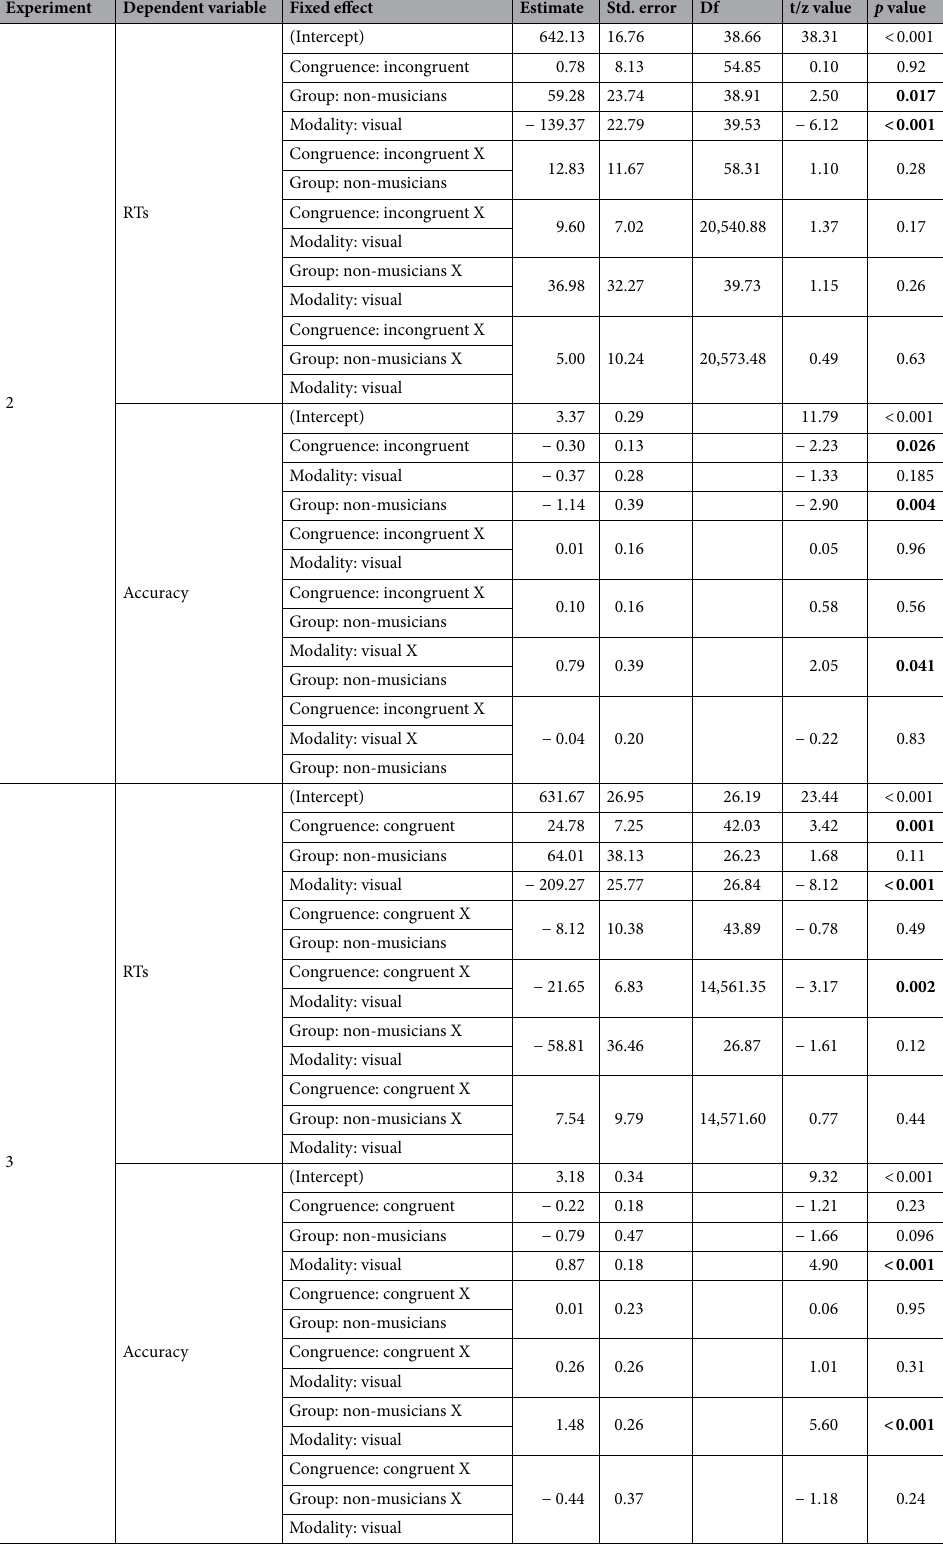
Table 1. Fixed effects results in Experiments 1, 2 and 3. Bold values represent significant fixed effects or